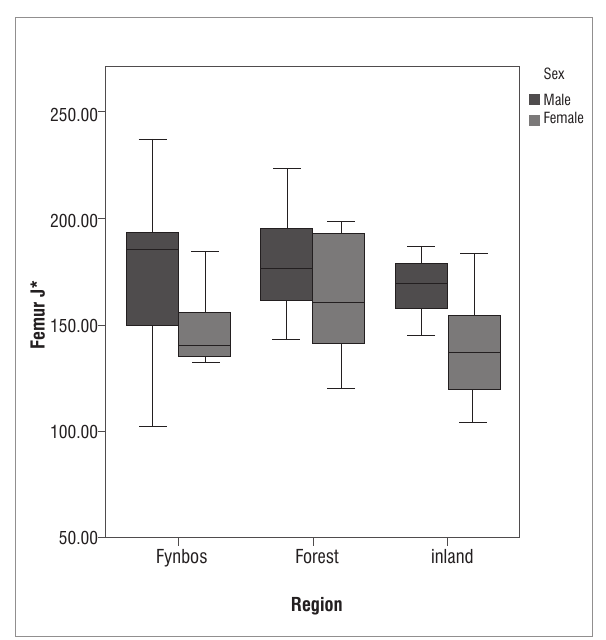
Figure 5: Comparison of femur torsional strength (J^, mm 4 ) for the lower Orange River Valley (inland), fynbos and forest samples. Forest women display femora that are more robust than those of inland and fynbos women. This suggests that they may have been more terrestrially mobile than their fynbos and Karoo counterparts. These results indicate a lower degree of sex-based differentiation in terrestrial mobility in the forest during the LSA as compared to other regions of the southern African Cape. The shared pattern of higher sexual dimorphism in femoral CSG properties between men and women of inland and fynbos regions suggests that a similar sex-based differentiation of terrestrial mobility may have occurred in these two regions. This may reflect a similar division of labour between men and women in terms of mobility. However, limited conclusions can be drawn because of the small sample sizes.